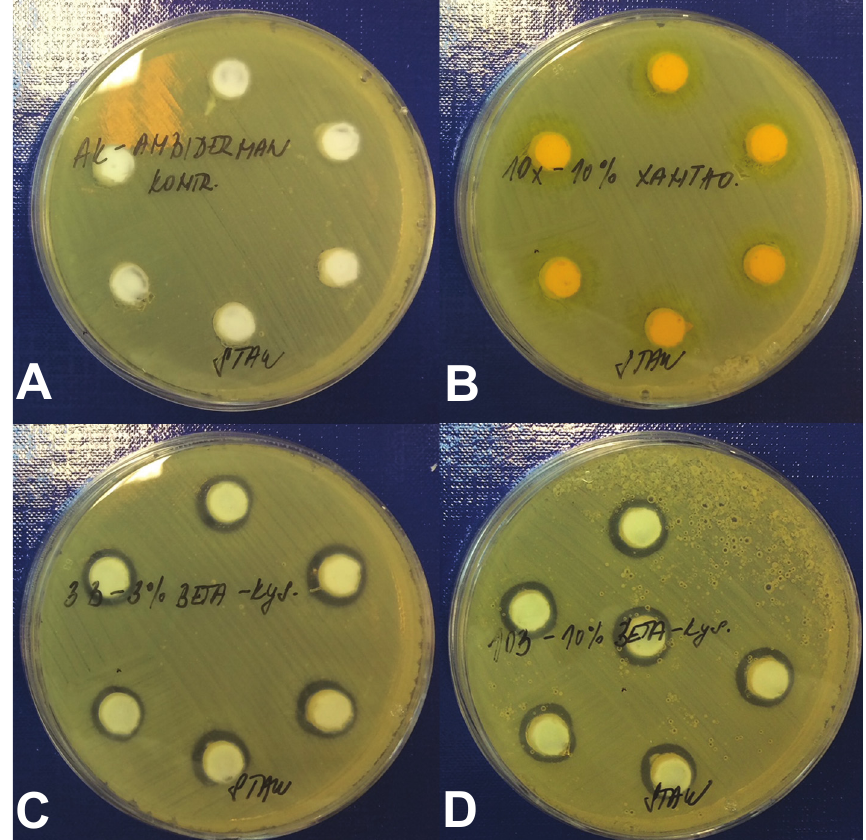
Figure 1. Antimicrobial activity of hop compounds in vitro. Agar diffusion test was performed using MRSA and compounds applied in Ambiderman base. ( A ) Ambiderman base only (negative control), ( B ) 10% xanthohumol, ( C ) 3% beta-acids and ( D ) 10% beta-acids. Inhibition zones. Table 1. The antimicrobial activity of hops compounds against the MRSA strain obtained by the agar diffusion